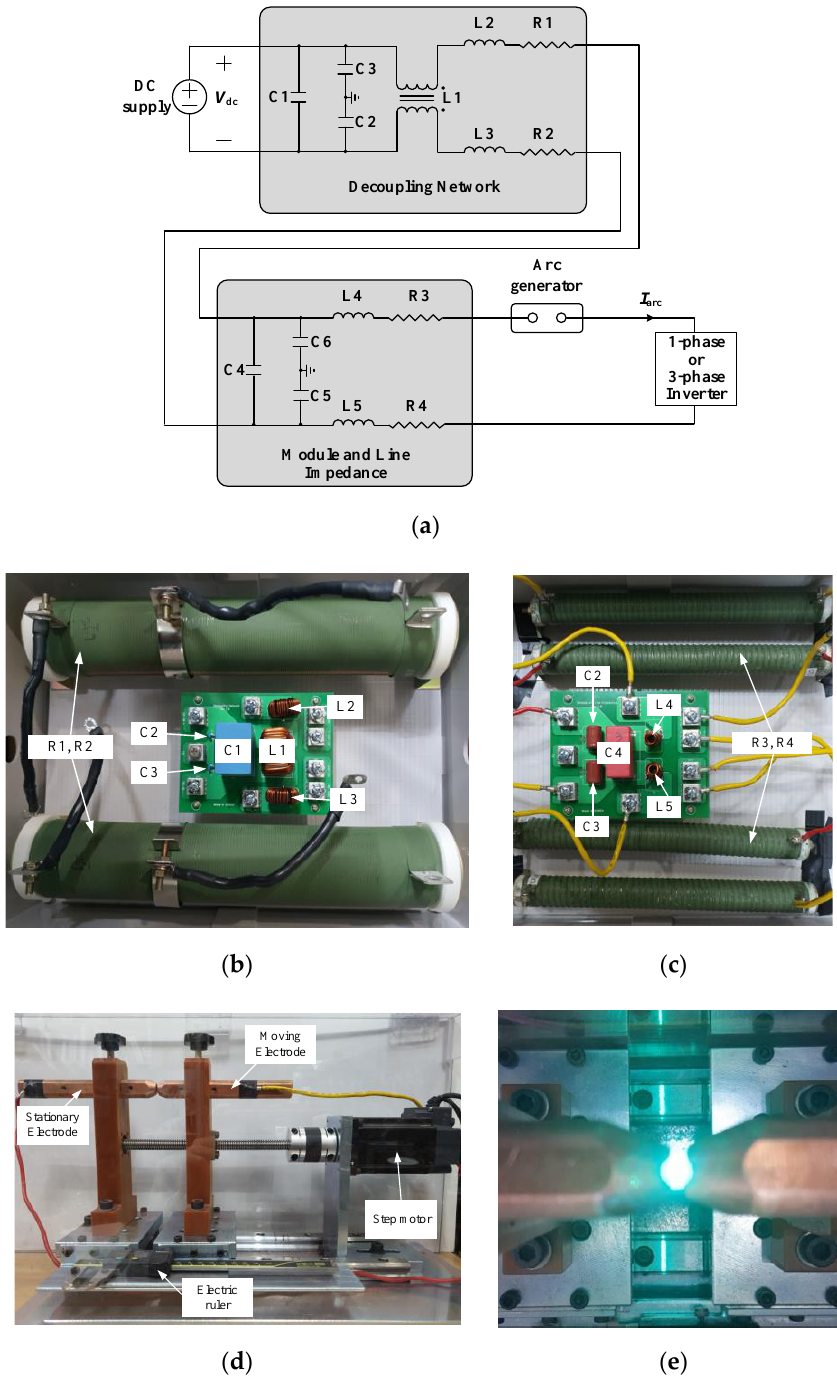
Figure 1. ( a ) Arc generation experiment setup; ( b ) decoupling network; ( c ) module and line impedances; ( d ) arc generator; ( e ) arc generation.